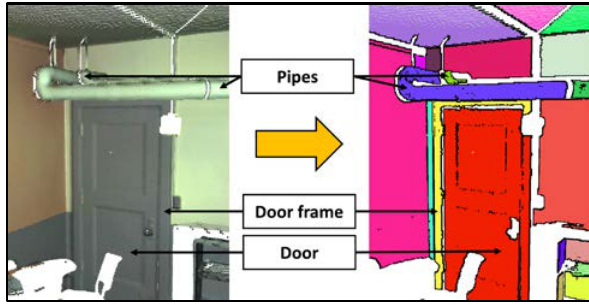
Figure 5. Close-up view of the segmentation result with the borders colored in black at the door and pipes.